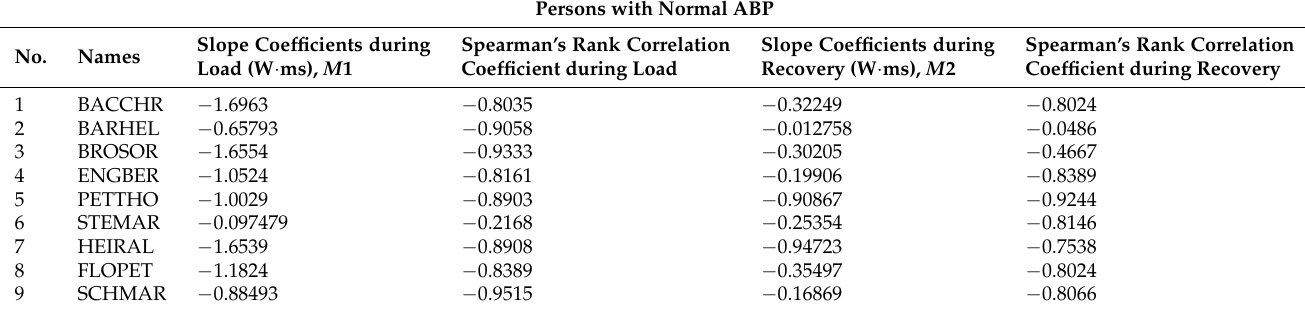
Table 1. Slope coefficients for individuals with normal ABP during the load and recovery. The good- ness of the linear regression fit (for each individual slope coefficient) is measured by the Spearman’s rank correlation coefficient.